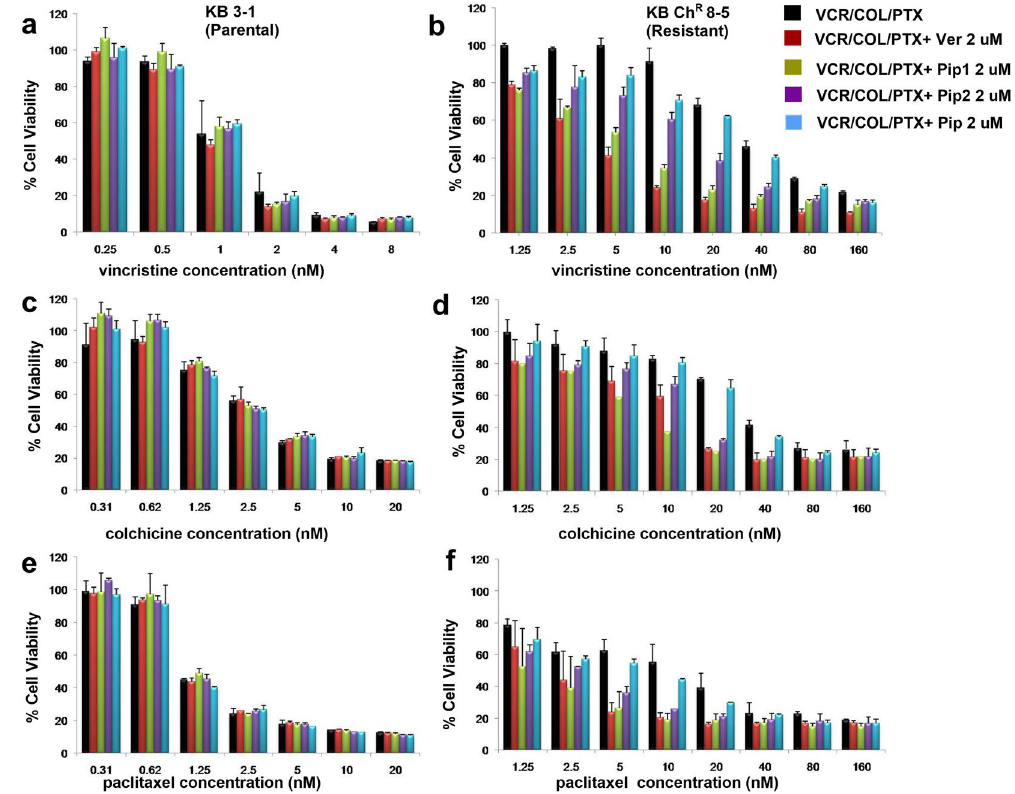
Figure 6. Cytotoxicity of vincristine (VCR) in ( a ) KB 3–1 (parental), and ( b ) KB Ch R 8–5 (resistant); colchicine (COL) in ( c ) KB 3–1 (parental), and ( d ) KB Ch R 8–5; paclitaxel (PTX) in ( e ) KB-3–1 (parental), and ( f ) KB Ch R 8–5 cells. The cells were treated either with VCR/COL/PTX alone or in combination with Verapamil (Ver), Pip1, Pip2 or piperine (Pip) (the concentration of Ver, Pip, Pip1 and Pip2 were chosen at which the cell viability was more than 95% both in KB 3–1 and KB Ch R 8–5 cell lines). Values with error bars represent the mean ± SEM of two or three independent experiments, each done in triplicates.